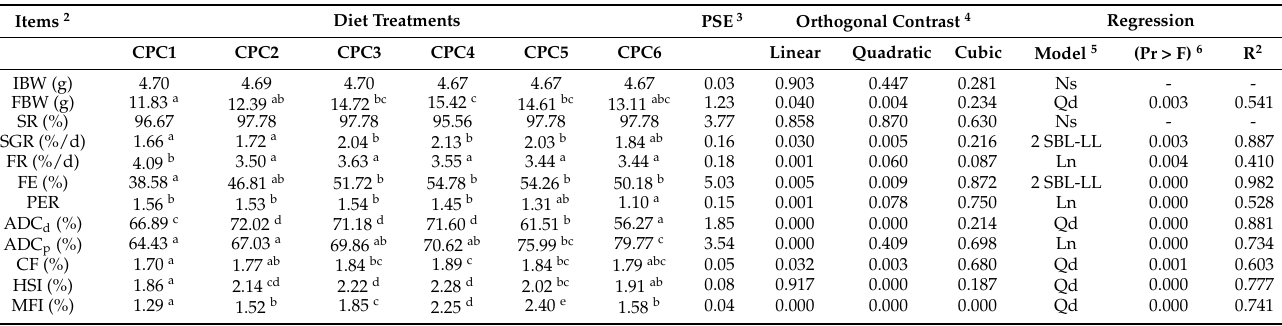
Table 3. Effects of dietary protein levels on the growth, apparent digestibility, and morphological parameters of grass carp 1 .